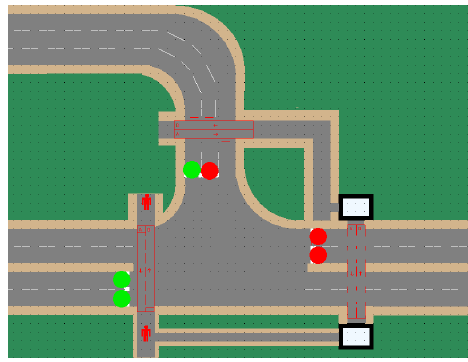
Figure 14. 2D intersection model.